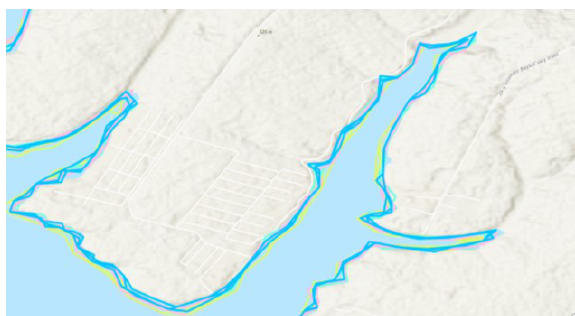
Figure 4 . Ground-truth and forecasting water surface boundaries